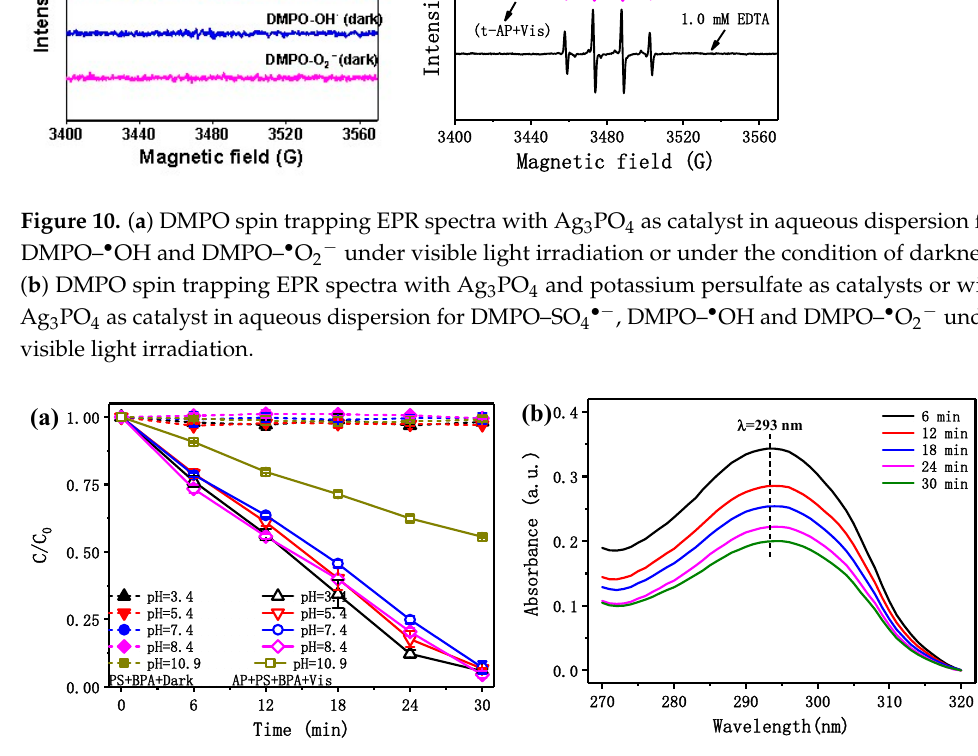
Figure 11. ( a ) The effect of different pH values on removal efficiency of bisphenol A with Ag 3 PO 4 and potassium persulfate as catalysts under visible light irradiation or with potassium persulfate as catalyst under conditions of darkness; ( b ) temporal spectral changes of aqueous solutions of bisphenol A with Ag 3 PO 4 and potassium persulfate as catalysts under visible light irradiation at pH = 10.9.